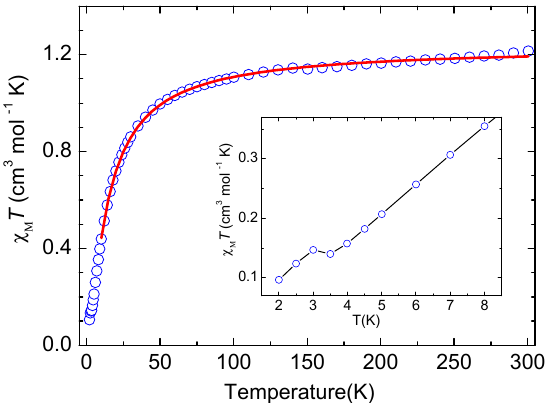
Figure 5. Plot of χ M T vsd. T of compound 1 from 2 to 300 K with a 1 kOe of applied field. The solid line represents the best fit. The inset shows the low-temperature region.